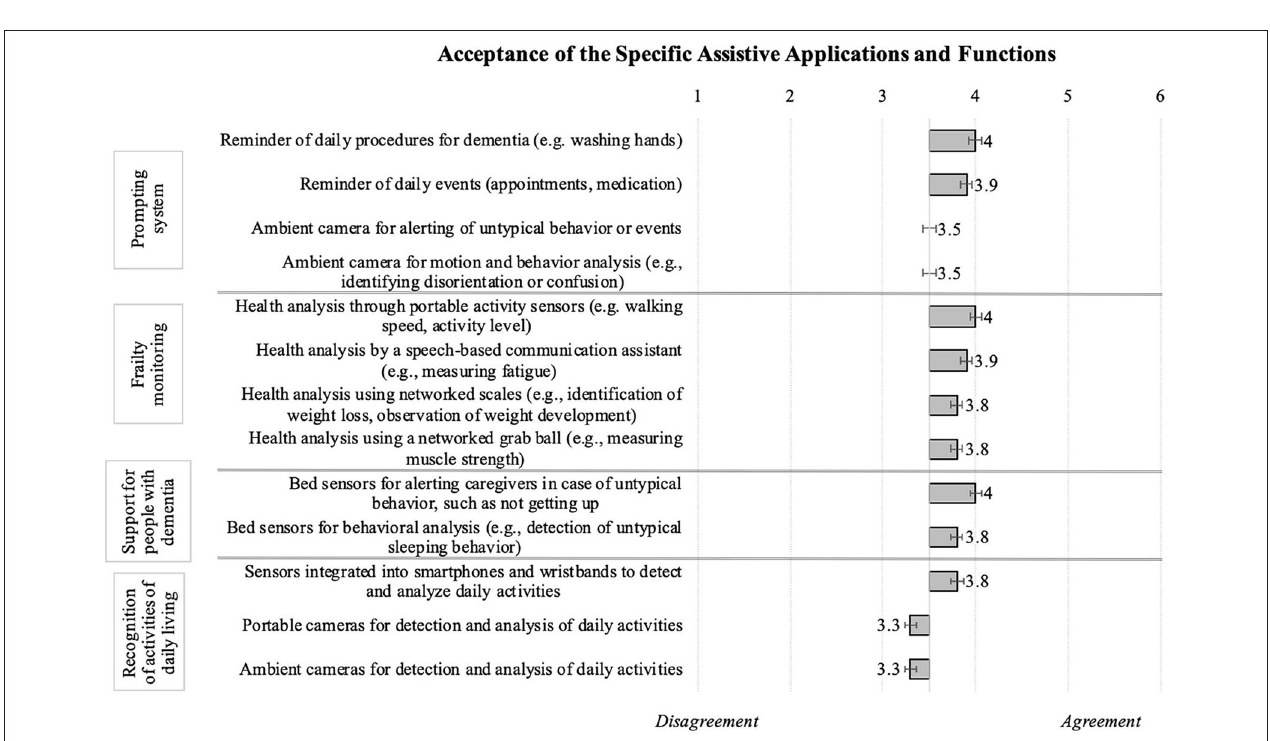
FIGURE 7 | Influence of health status on the perceived advantages (Left) and impact of gender on the perceived disadvantages (Right) of using assistive technology ( N = 384).